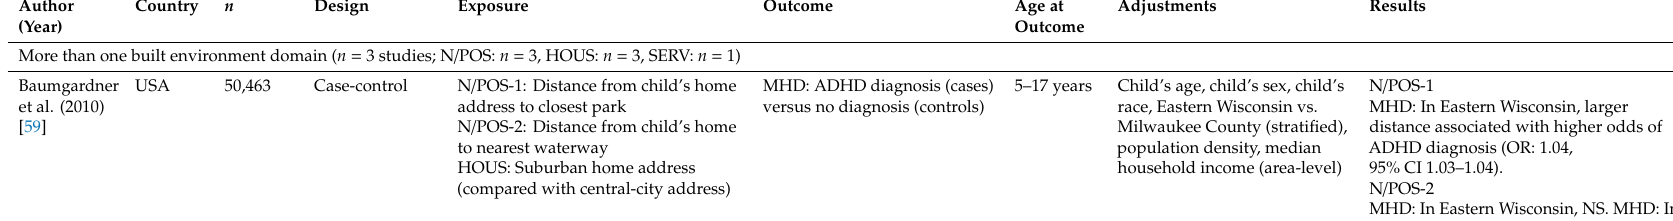
Table 1. Quantitative studies included in this